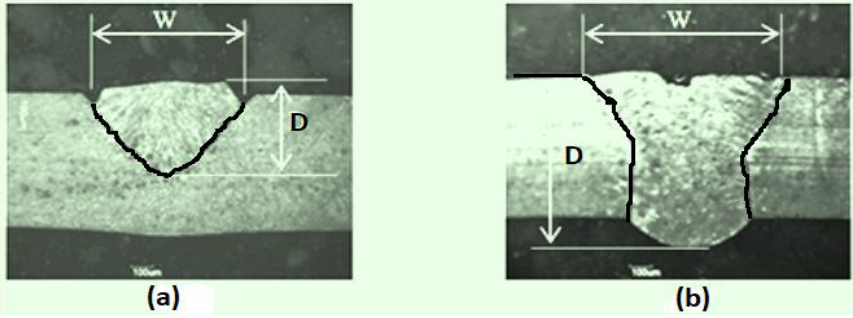
Figure 9. ATIG (optimal flux) and TIG (conventional) welded beads morphology.